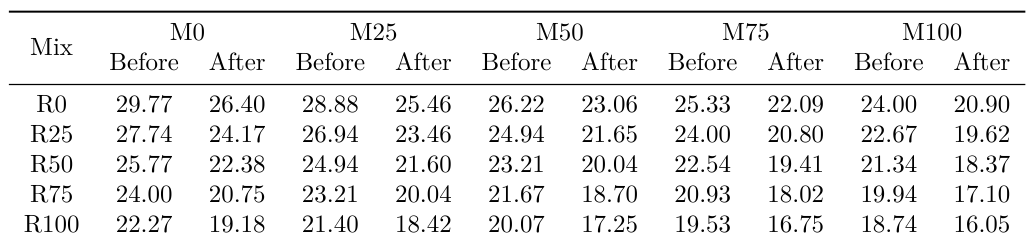
Table 5. Compressive strength of SCC mixtures after 56 days of acid immersion.